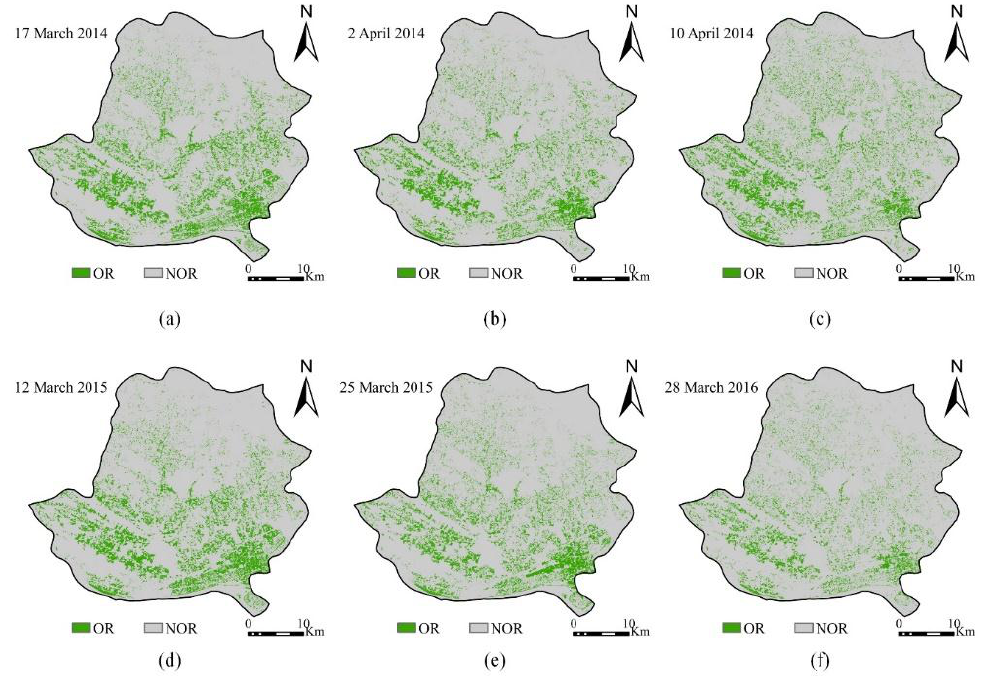
Figure 10. CSRA-derived oilseed rape maps on ( a ) 17 March 2014; ( b ) 2 April 2014; ( c ) 10 April 2014; ( d ) 12 March 2015; ( e ) 25 March 2015; and ( f ) 28 March 2016 in Wuxue City. Table 2. Accuracy assessment for CSRA-derived oilseed rape maps in Wuxue City.